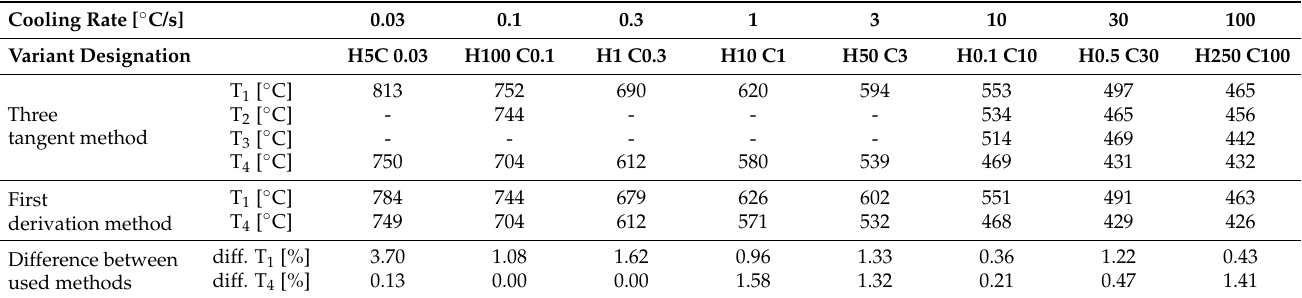
Table 7. The transformation temperatures of austenite decomposition.